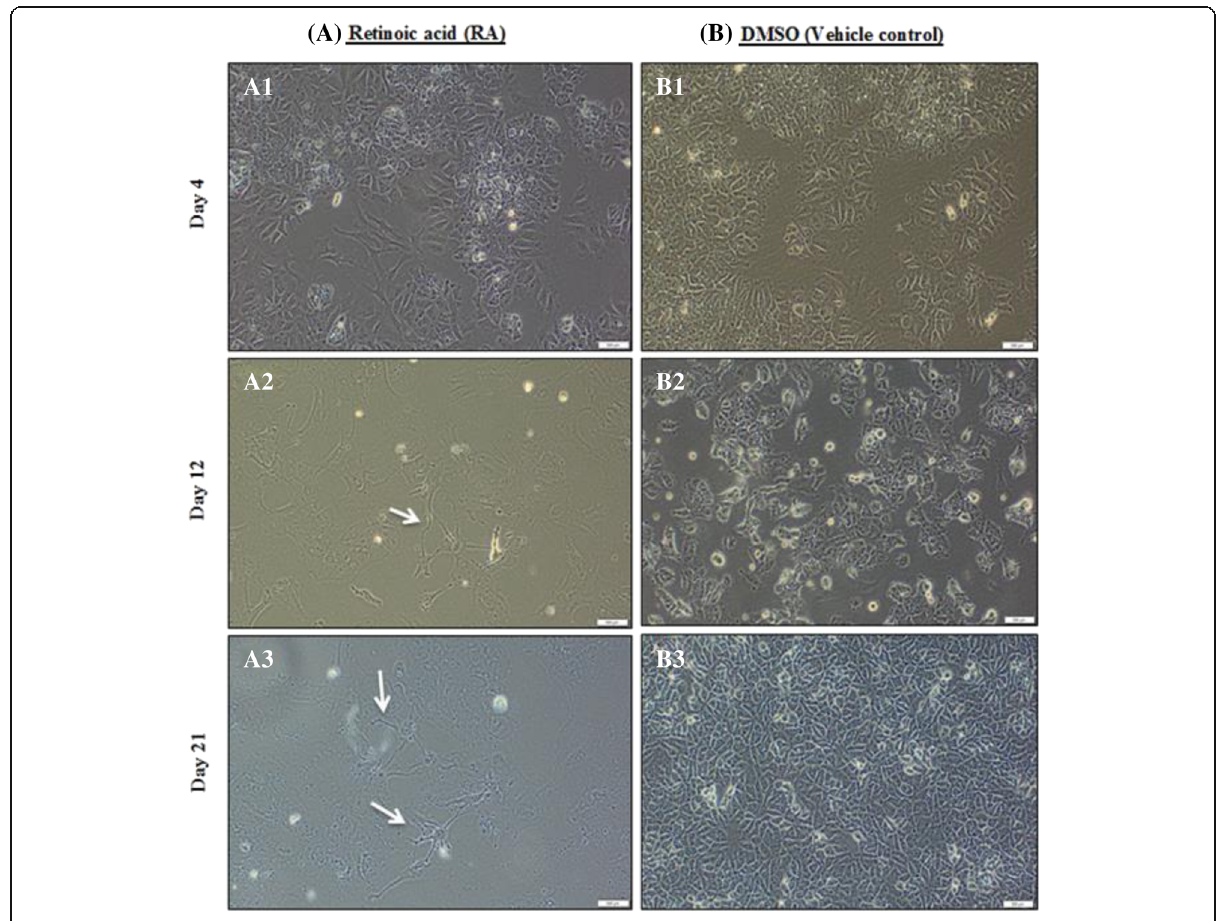
Fig. 7 Differentiation of NT2 cells into postmitotic neurons when incubated with 10 μ M RA. (A1) On day 4, the morphology of NT2 cells with 10 μ M RA had begun to change. (A2) On day 12 and (A3) day 21, the NT2 cells showed neuronal morphology with an extended network over the surface of the culture. (B1, B2 and B3) Vehicle control (0.001% DMSO) cells maintained their morphology over 21 days. Scale bar, 500 μ m. Magnification (10×). Arrows indicate neuronal morphology with extended